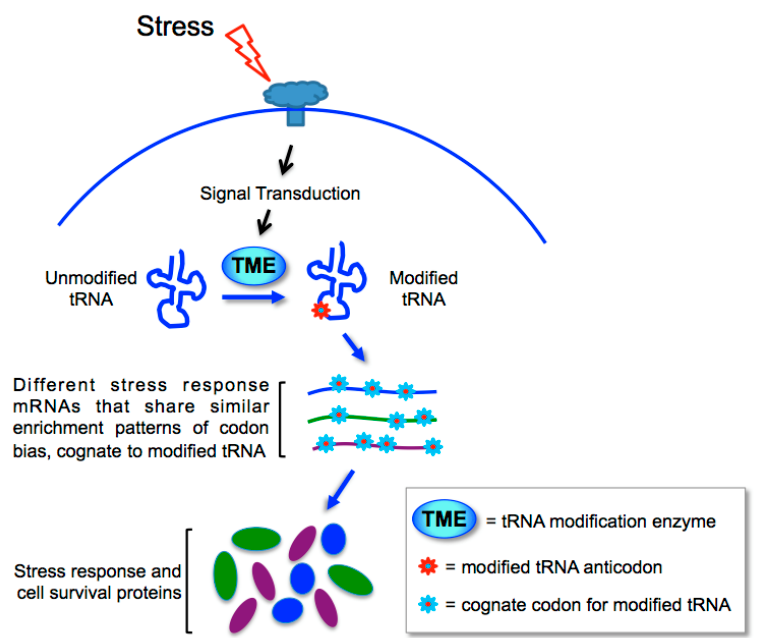
Figure 4. General model for how tRNA modifications can be keyed to a cellular stress response. Upon stress, the modification efficiency of a particular tRNA, usually at the wobble nucleotide,